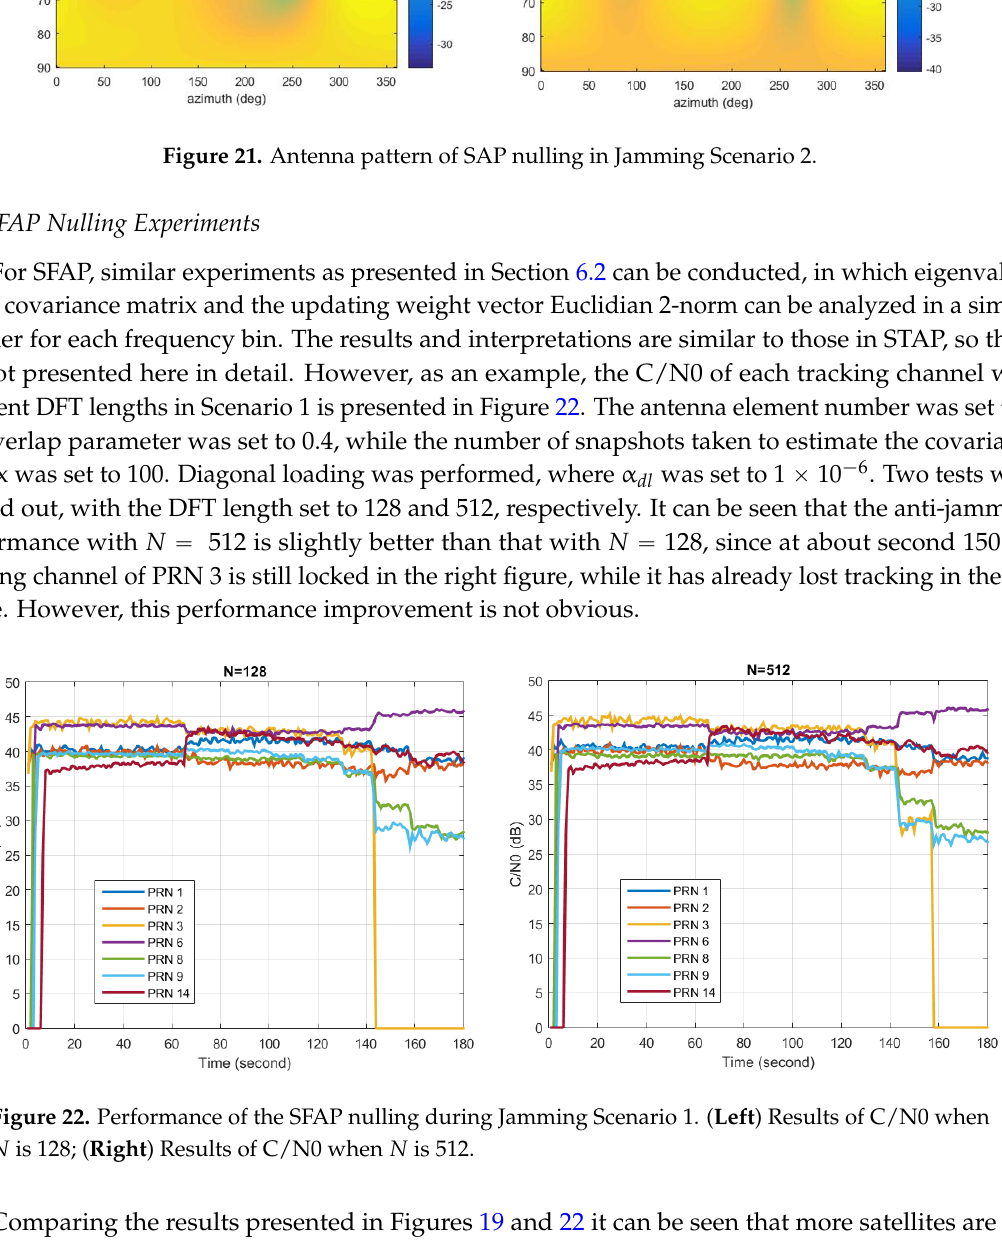
Figure 21. Antenna pattern of SAP nulling in Jamming Scenario 2.